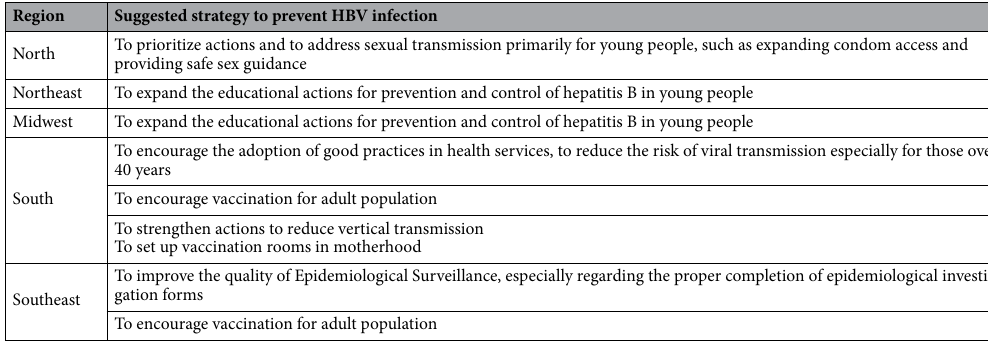
Table 5. Suggestions of strategies as part of a multi-pronged approach to reducing burden of HBV infection considering the different regional realities in Brazil.